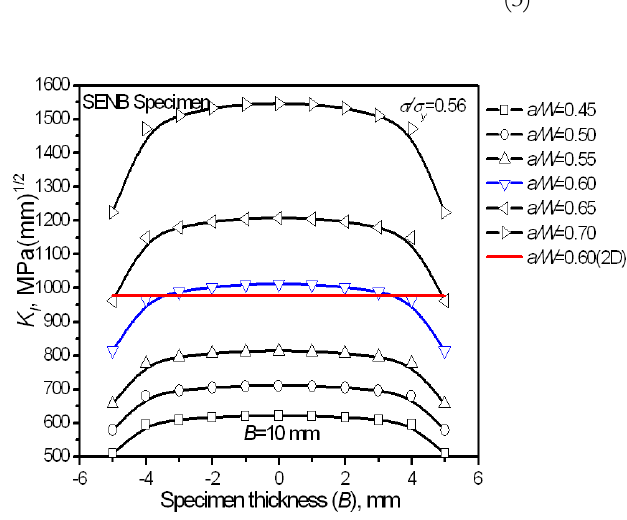
Figure 5: Variation of K various a/W.